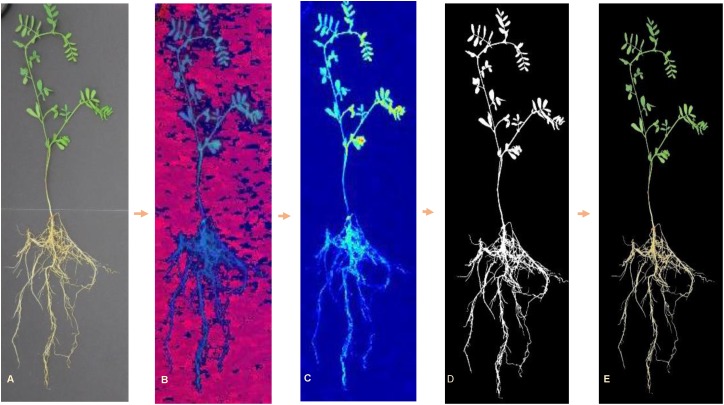
RGB image processing steps for background removal: (A) original RGB image, (B) HSV image, (C) hue channel image, (D) resulting mask, and (E) RGB image with background elimination.